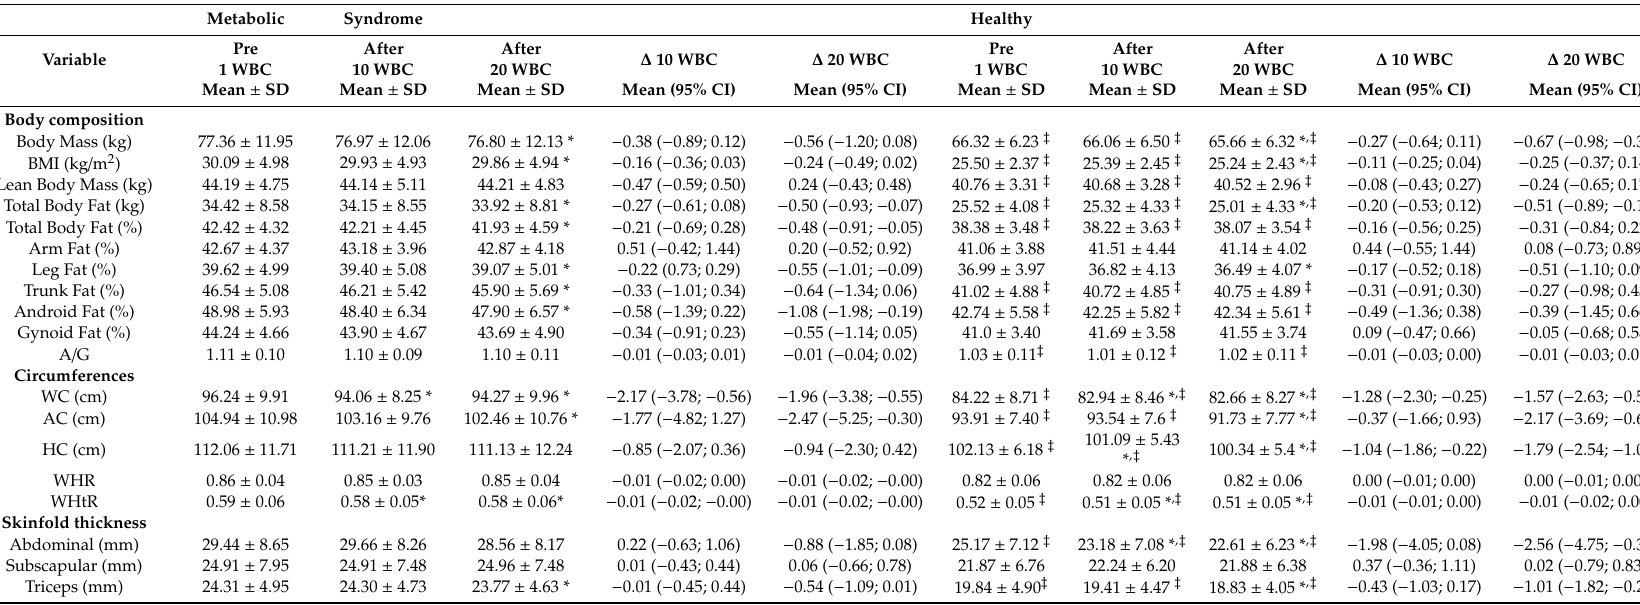
Table 4. Changes in body composition, circumferences and fatfold thickness as an e ff ect of applying whole-body cryotherapy (WBC)